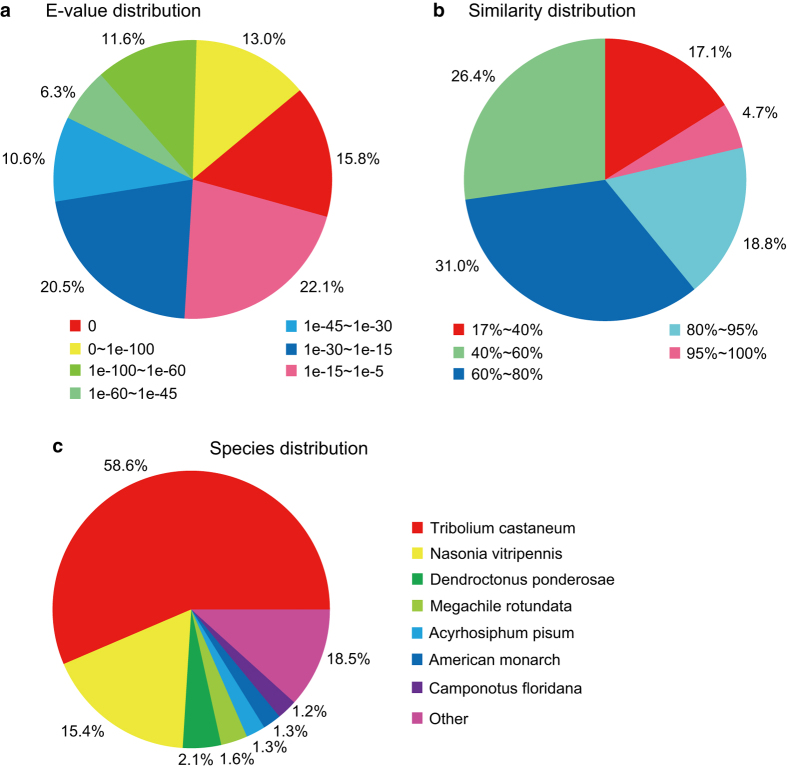
Pie-charts presenting the distribution of E-values, sequence identities, and most closely related insect species resulting from annotation with the nr database.